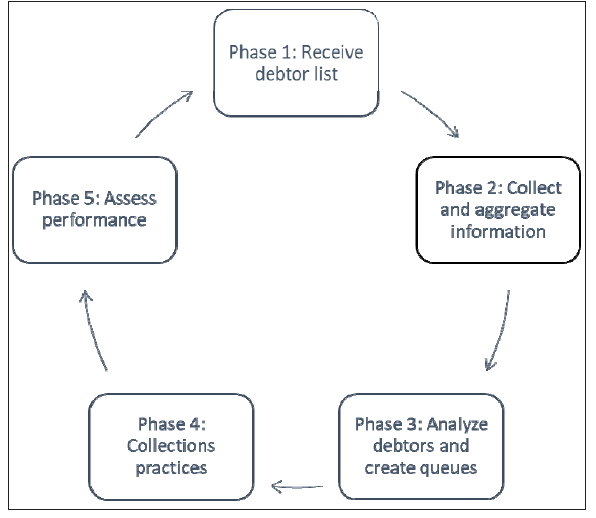
Figure 1: Operational phases of a debt collections